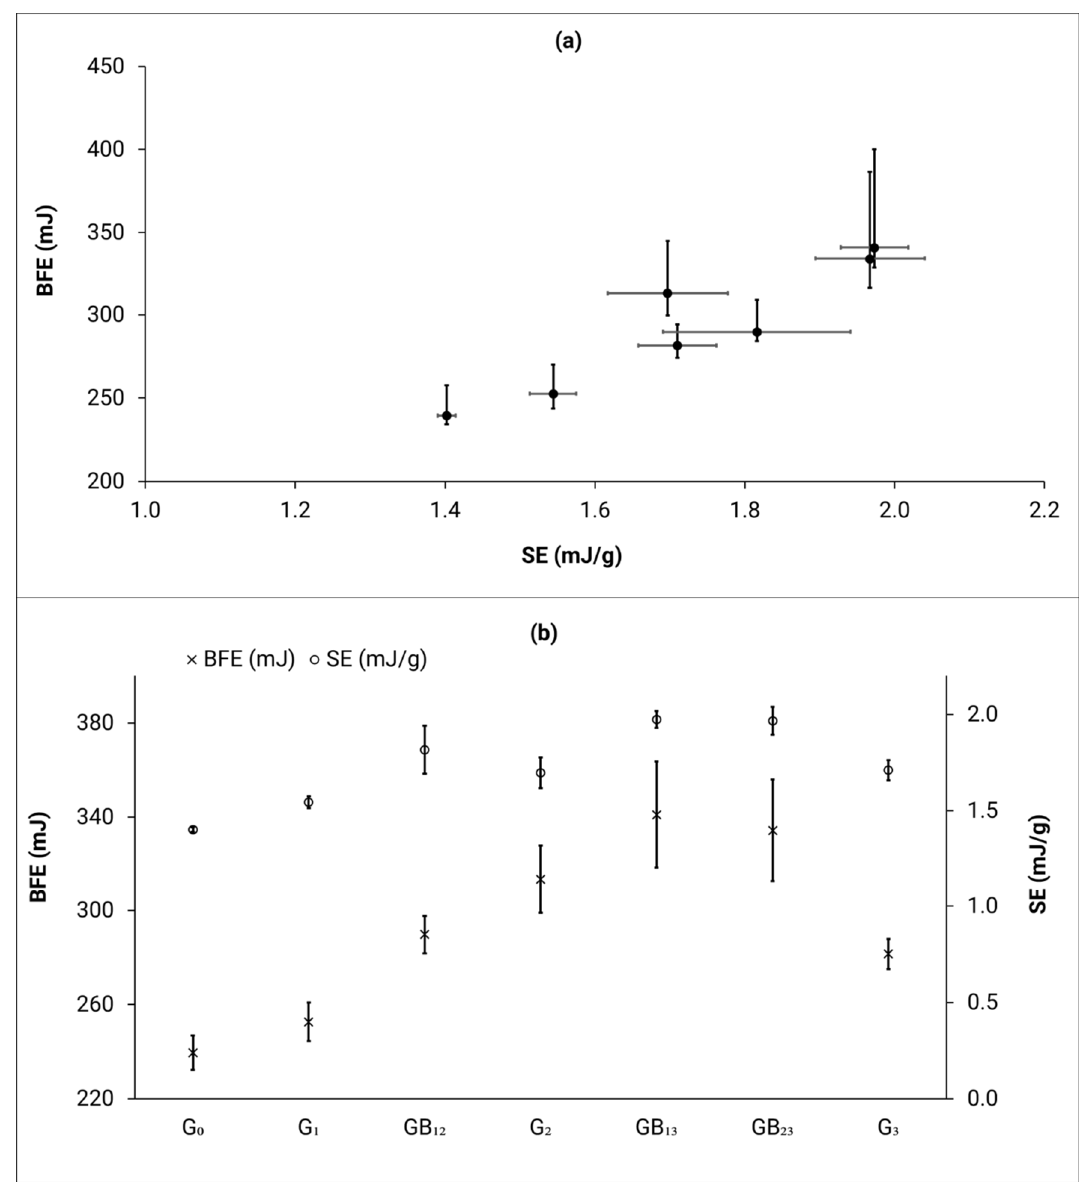
Figure 5. ( a ) BFE vs. SE, ( b ) BFE and SE values; for all powder types. Error bars represent the min–max range.